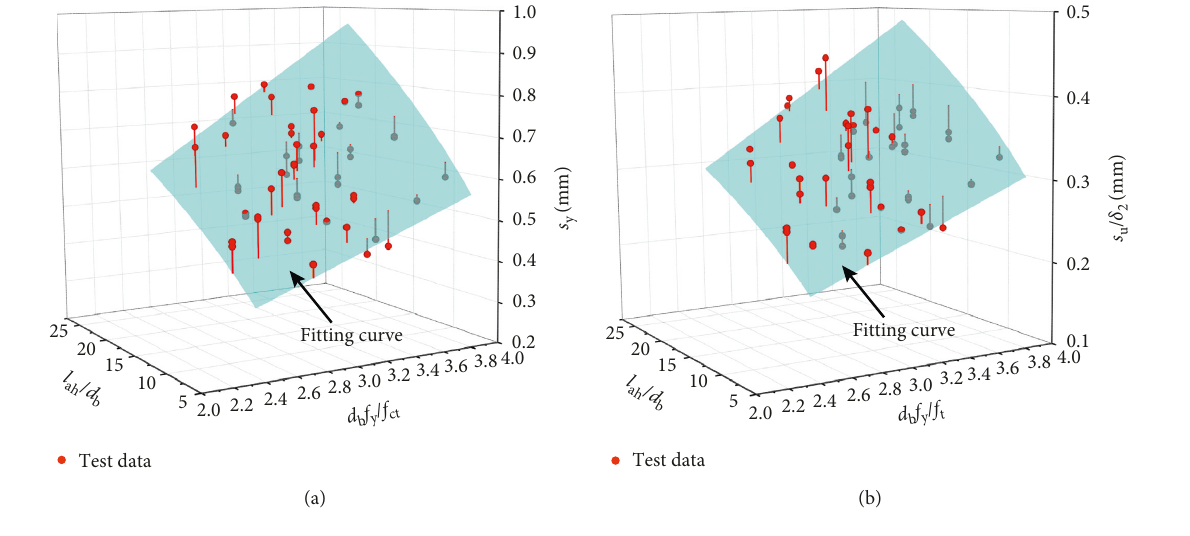
Figure 21: Fitting curves of (a) s Table 10: Results of slippage s